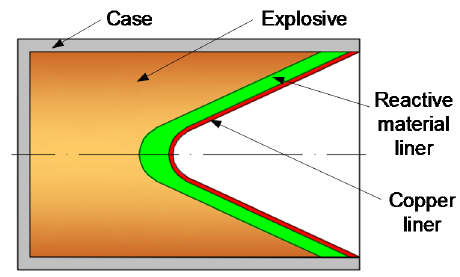
Figure 1. Typical configuration of a reactive material-copper liner (RM-CL) shaped charge.